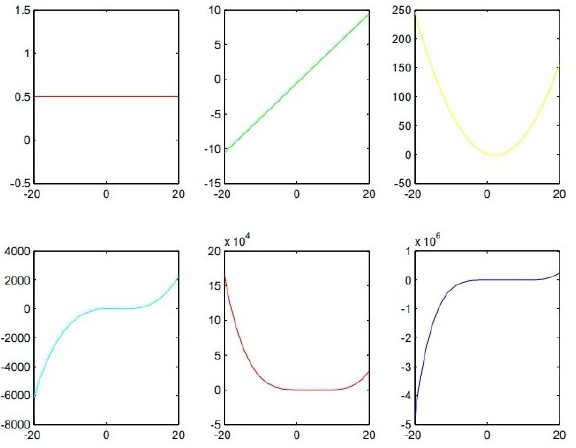
Figure 2. Polynomials of the Example